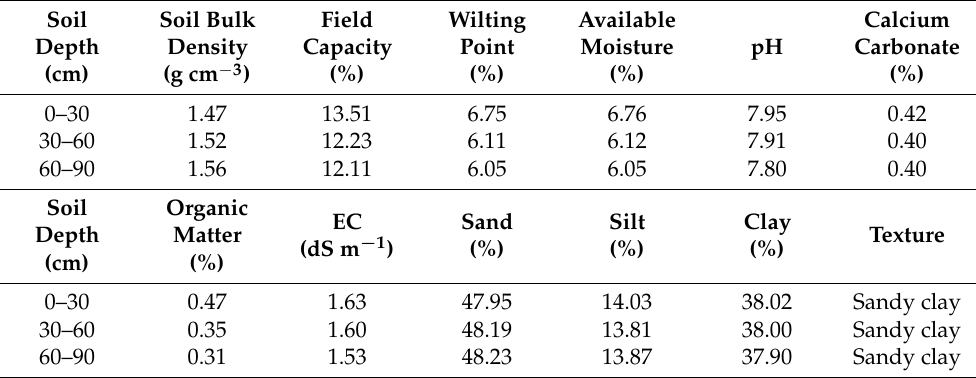
Table 2. Chemical and physical properties of the experimental field soil (averaged over two seasons: 2019 and